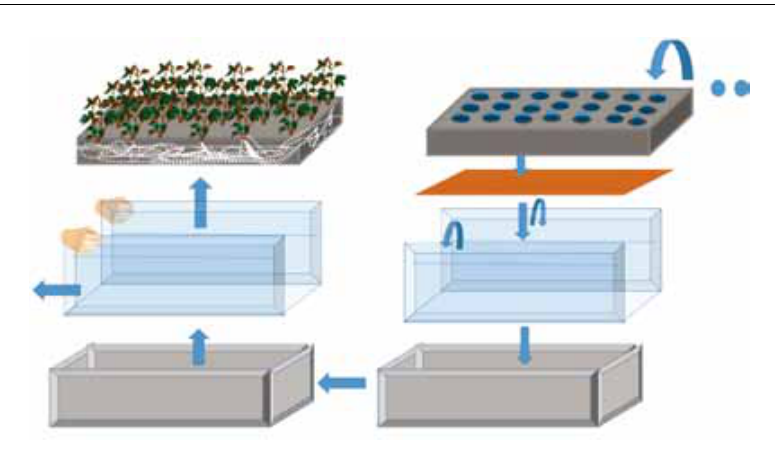
Figure 1 . Diagram of nurse­in­tray plantlet production. (Explanation provided in the text.)